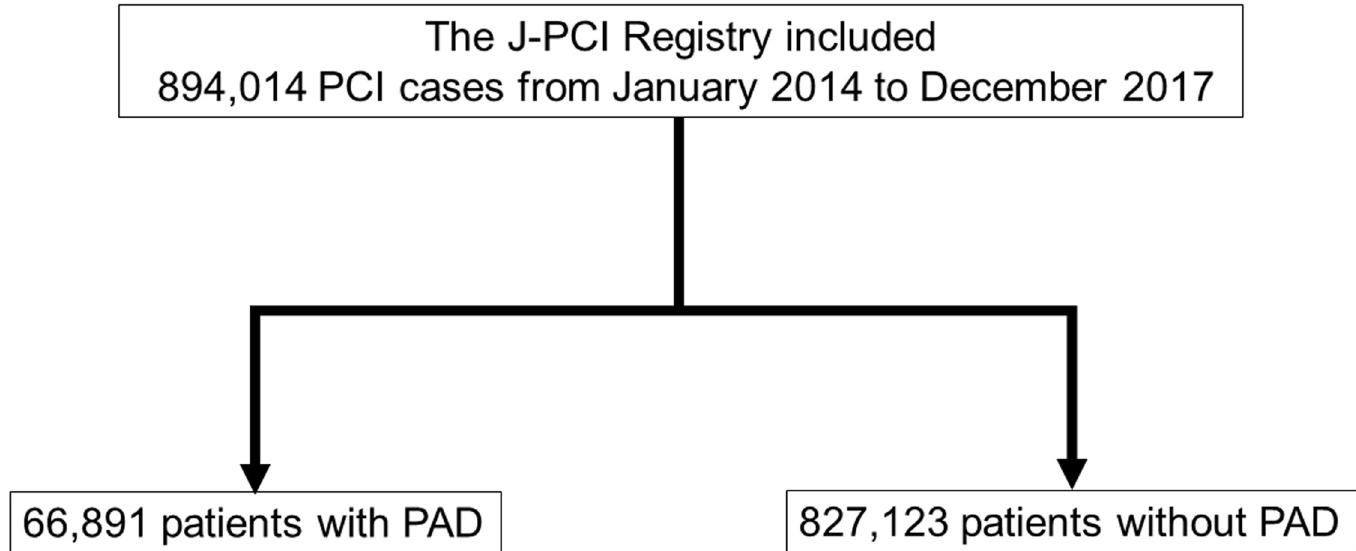
Fig 1. The study flow chart. The J-PCI Registry included 894,014 PCI cases from January 2014 to December 2017. Of these, PAD was complicated in 8.1% of the patients. PCI: Percutaneous coronary intervention; PAD: Peripheral artery disease.